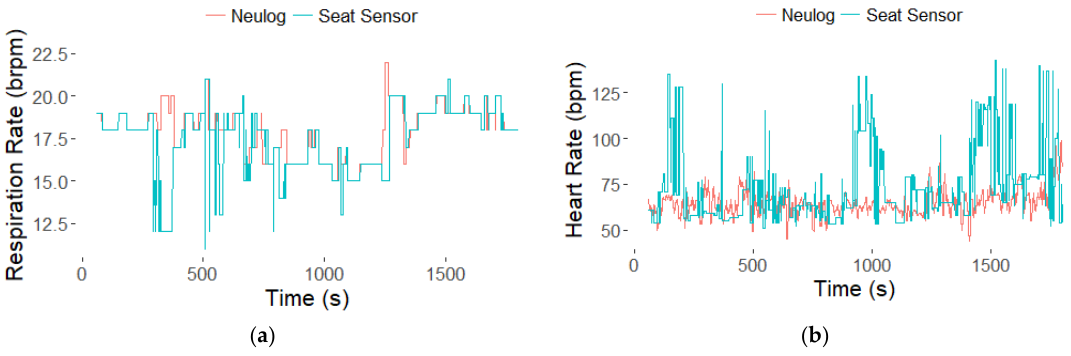
Figure 4. Example data from Participant 2 (P2). The respiration ( a ) and heart ( b ) rate time courses from the seat sensor using the frequency analysis (FFT) technique.